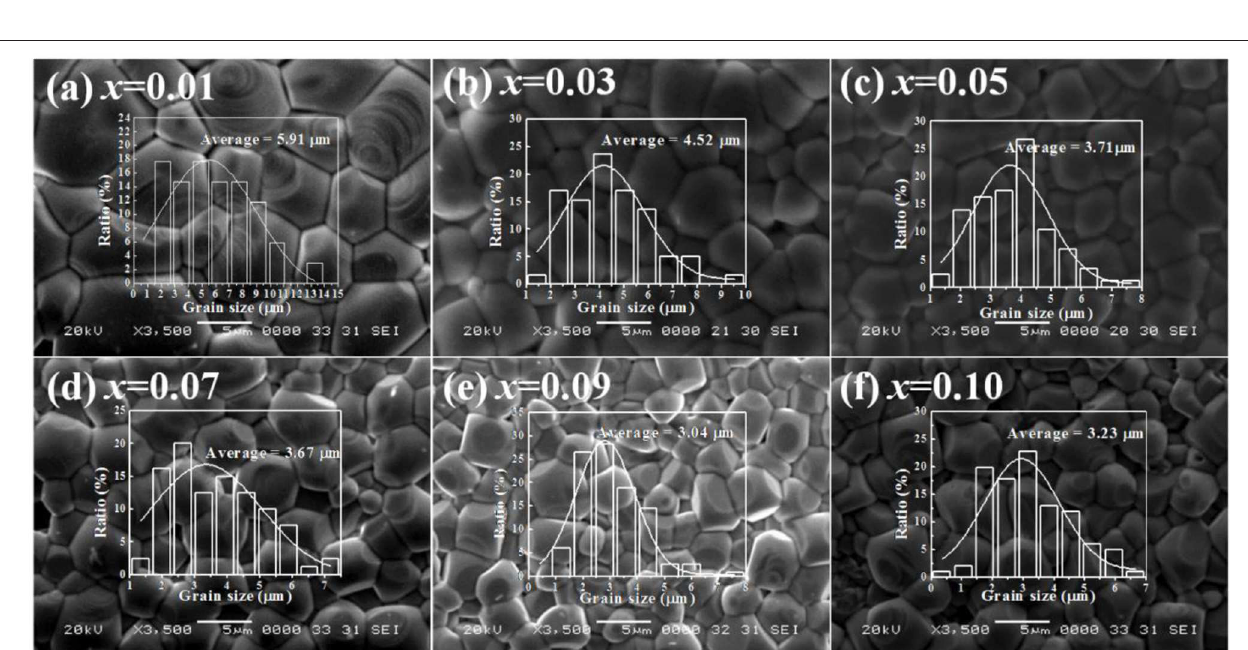
FIGURE 1 | (A) XRD patterns of BNKT- x FSN ceramics, (B) the magnified view of the (200) peaks.